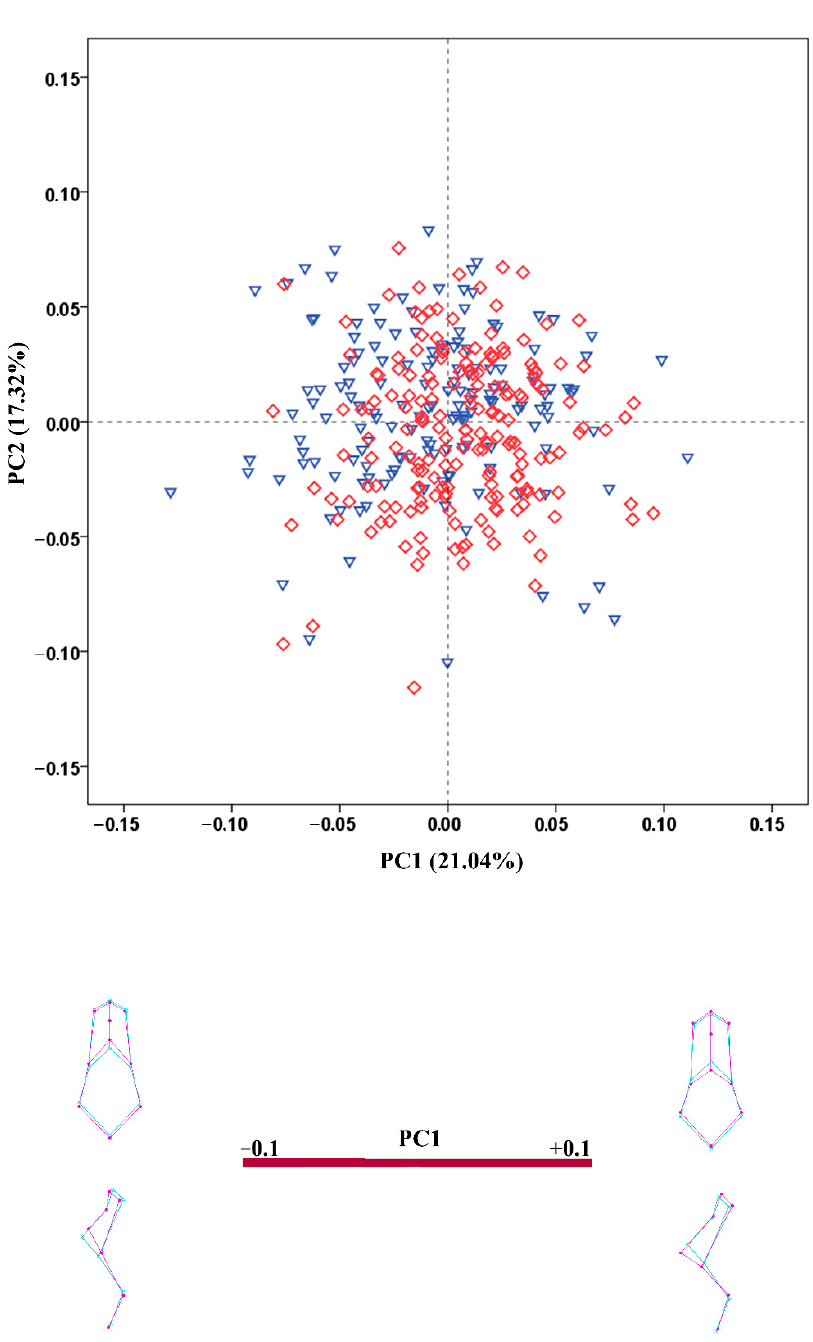
Figure 5. PCA scatterplot for the configuration of the nasal region. The wireframes illustrate the shape variation along the axis of PC1. Male crania—blue triangles; female crania—red rhombs; extreme shape configurations—purple wireframes; mean shape configuration—light blue wireframe.